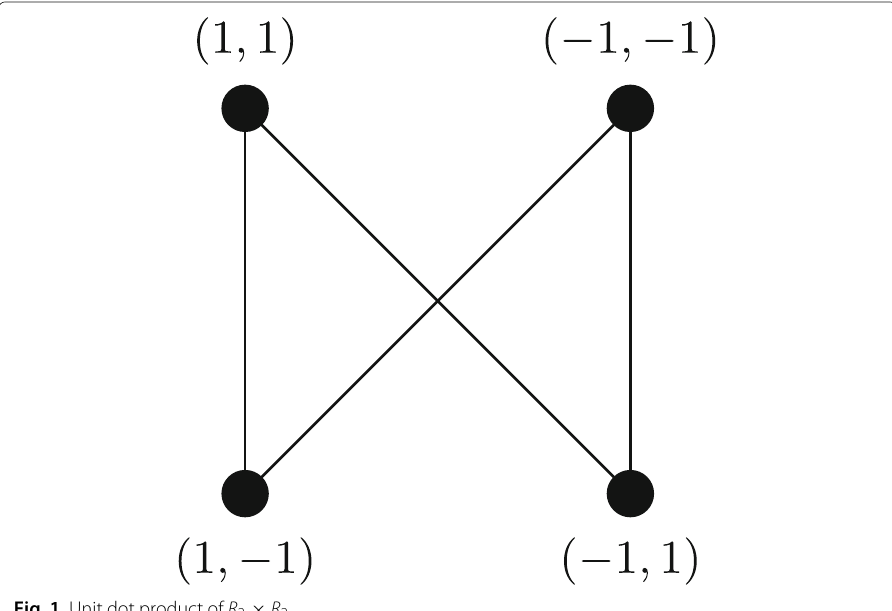
Fig. 1 Unit dot product of R 2 × R